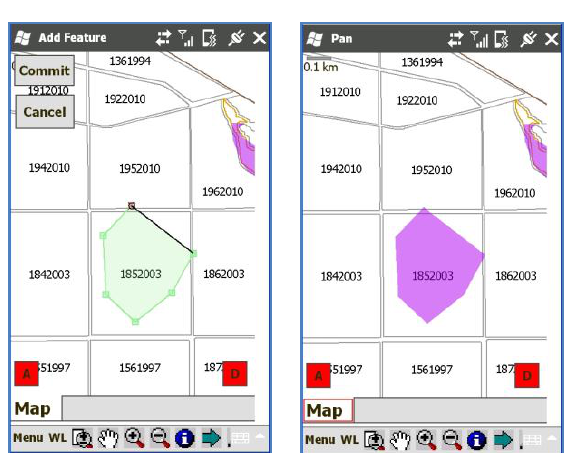
Figure 7. Map display and navigation tools